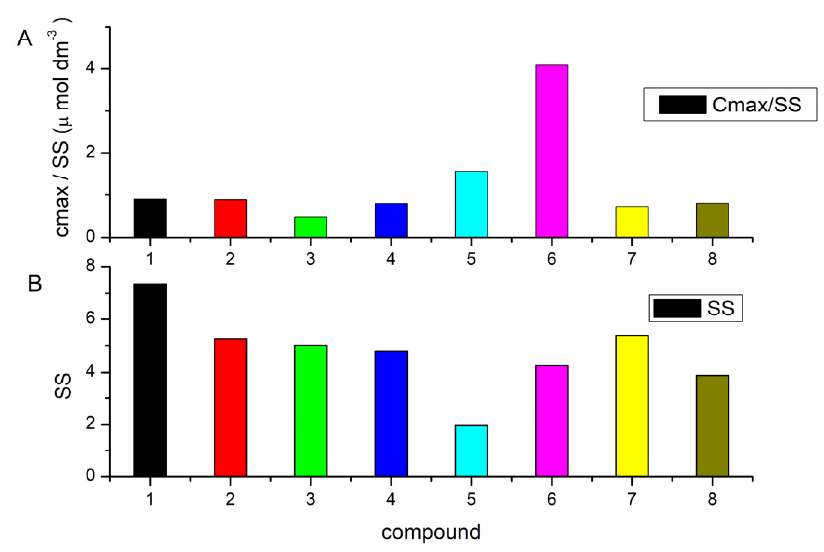
Figure 3. Ratio c max /SS ( A ) and specific sum SS ( B ) for 8 benzothiazole compounds.